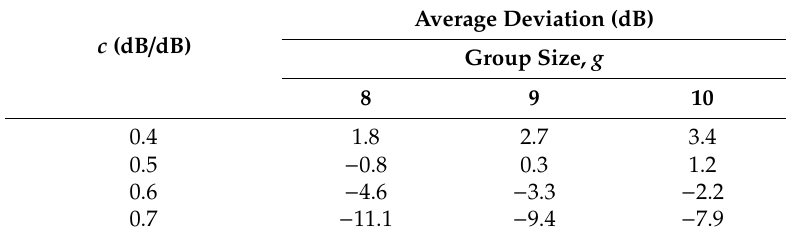
Table 1. Average deviations between predicted and measured noise levels in the living room, using A p = 0.2 m 2 and di ff erent values for the parameters c and g .